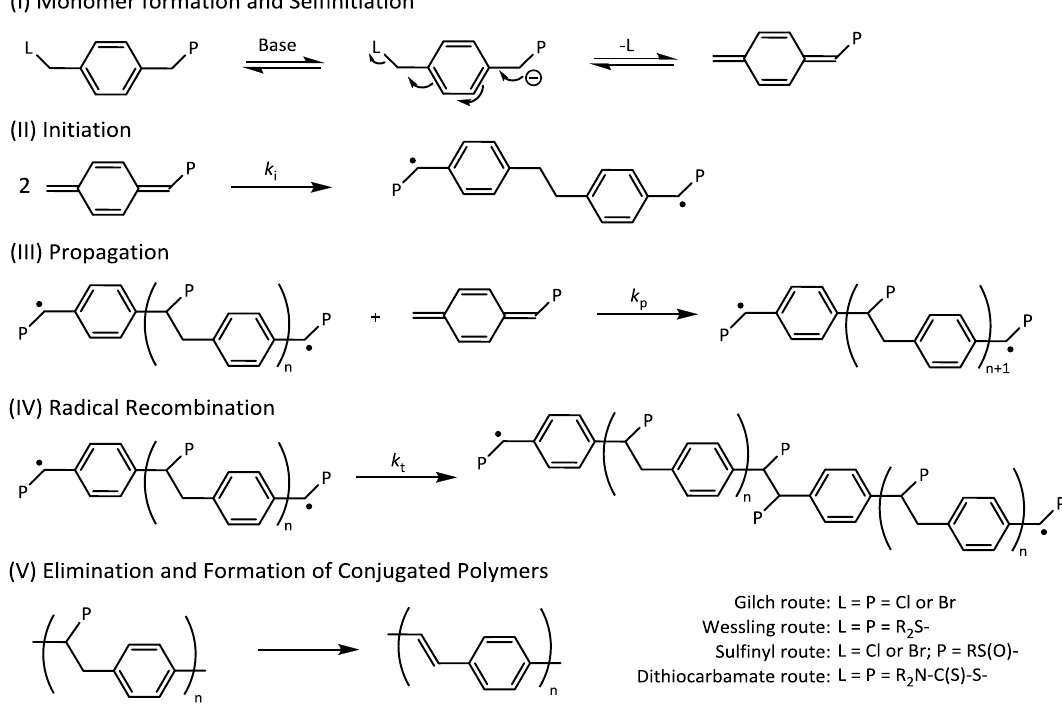
Scheme 8. Reaction mechanism of precursor polymerizations and subsequent conversion of precursor polymers to conjugated